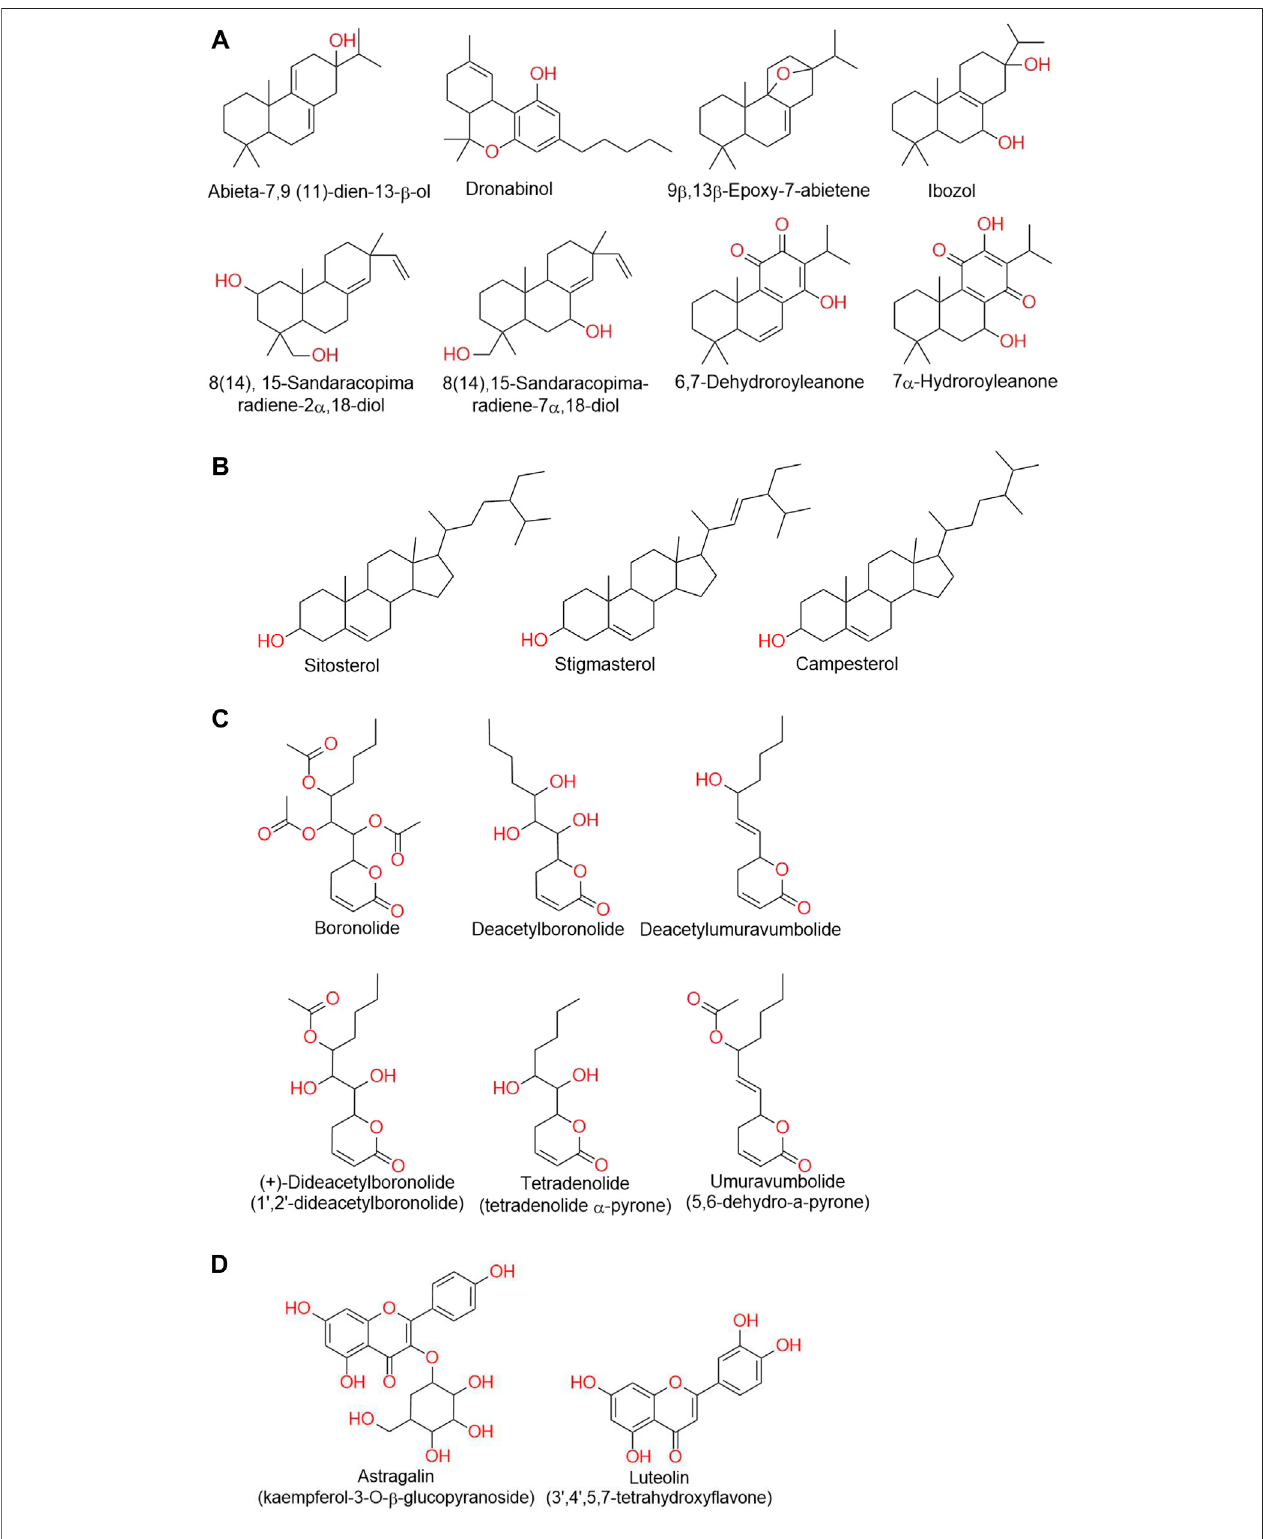
FIGURE3|(A) Chemicalstructureofabietaneandroyleanoneclassesofisolatedditerpenesfrom T.riparia. (B) Chemicalstructureofphytosterolsisolatedfrom T. riparia . (C) Chemical structure of α , β -unsaturated δ -lactonemoiety-bearing phytoconstituentsisolated from T. riparia. (D) Chemicalstructure of fl avonoidsisolatedfrom T. riparia